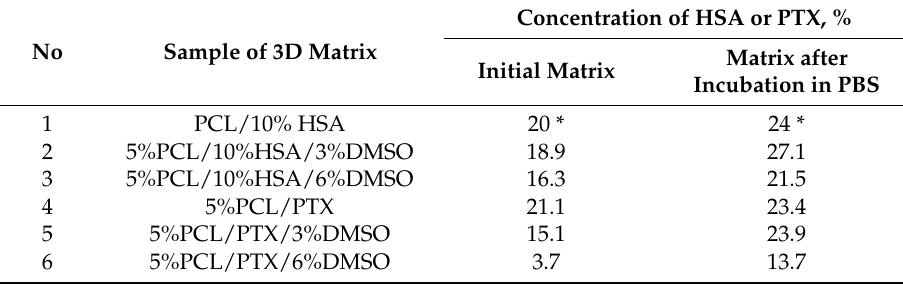
Table 3. XPS data on HSA and PTX surface concentrations in electrospun 3D matrices obtained from different PCL/HSA or PCL/PTX